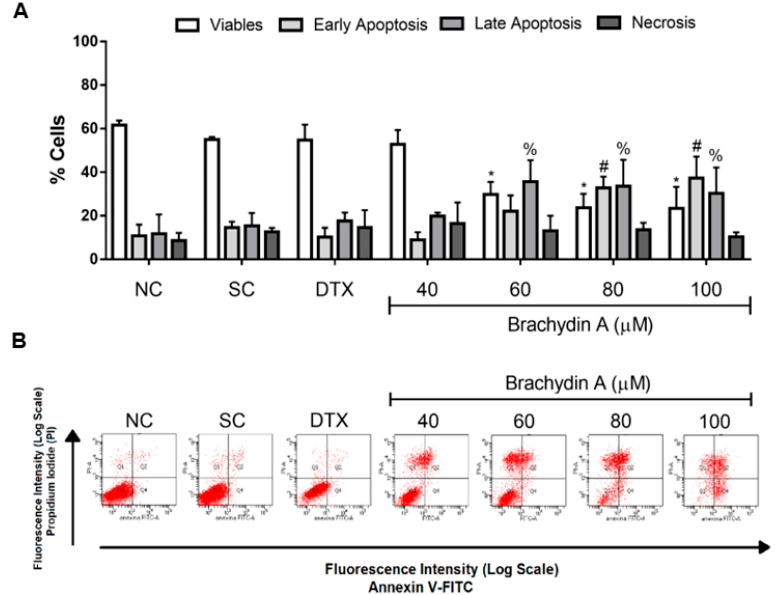
Figure 5. Flow cytometric analysis of DU145 spheroids treated with Brachydin A (BrA) for 72 h and respective controls and stained with Annexin V-FITC/propidium iodide (PI). ( A ) Percentage (%) of viable, early apoptotic, late apoptotic, and necrotic cells in DU145 spheroids after 72 h exposure with Brachydin A (BrA). The bars represent the mean ± standard deviation of eight ( n = 8) sphe- roids/replicates disaggregated in three biological experiments ( n = 3). *, # Values statistically differ- ent from the NC group ( p < 0.05; two-way ANOVA followed by Dunnett’s post-test). ( B ) Repre- sentative dot-plots of DU145 spheroids treated for 72 h with BrA. Lower left quadrant (Q3): negative cells for both Annexin V-FITC and PI; lower right quadrant (Q4): cells labeled with Annexin V (early apoptotic cells); upper left quadrant (Q1): cells labeled only with PI (necrotic cells); right upper quadrant (Q2): cells labeled with Annexin V and PI (late apoptotic cells). The bars represent the mean ± standard deviation of experiments with six ( n = 6) spheroids/replicates and three biological experiments ( n = 3). Values statistically different from the NC group for *early apoptosis; # late apop- tosis and % necrosis ( p < 0.05; ANOVA followed by Dunnett’s post-test). NC: negative control (RPMI 1640); SC: solvent control (1% DMSO); DTX: Docetaxel (50 μ M; positive control).